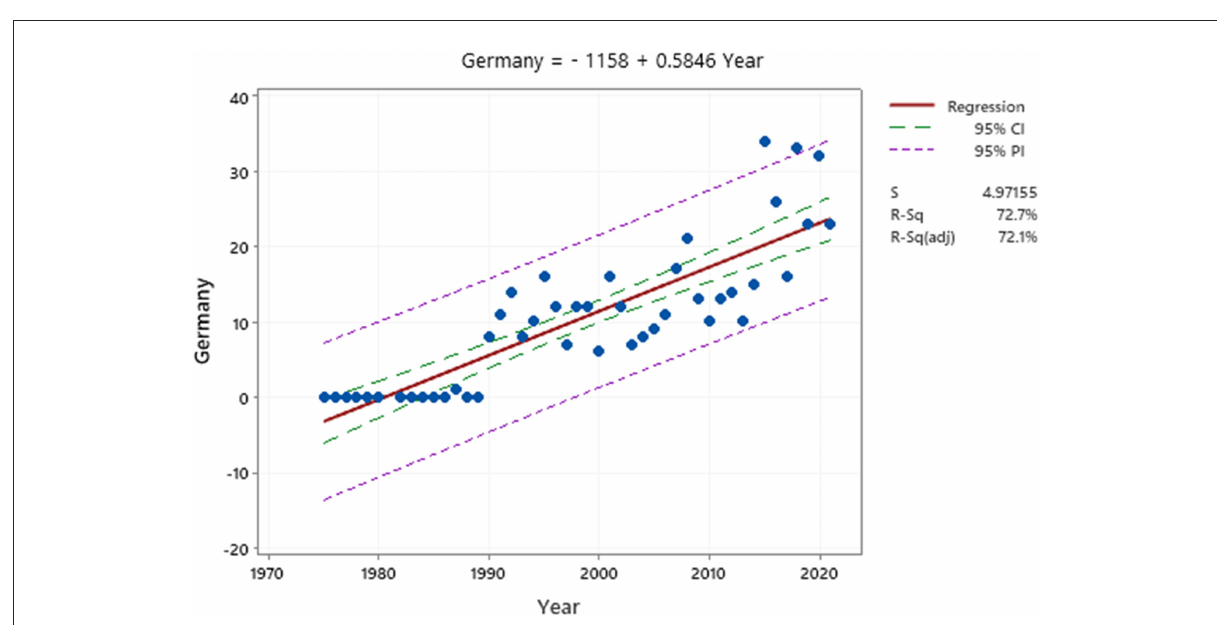
FIGURE5 Article production curve in